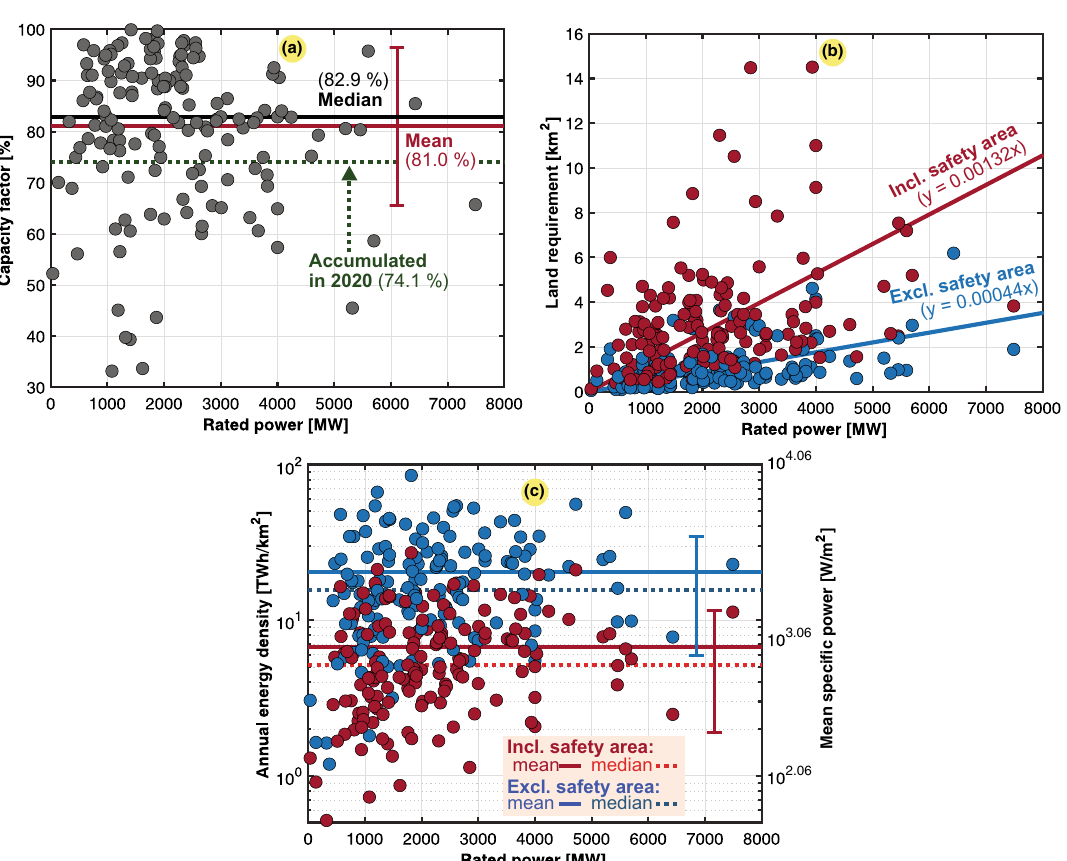
Figure 4. Scatter plots of the 159 nuclear power plants worldwide, 56 in Europe (1 in the Netherlands, 2 in Belgium, 19 in France, 6 in UK, 7 in Germany, 5 in Spain, 1 in Armenia, 2 in the Czech Republic, 2 in Finland, 1 in Hungary, 1 in Romania, 2 in Slovakia, 1 in Slovenia, 3 in Sweden, and 3 in Switzerland), 14 in the CIS (10 in Russia and 4 in Ukraine), 2 in the Middle East (1 in the United Arab Emirates and 1 in Iran), 1 in Africa (South Africa), 4 in Latin America (2 in Argentina, 1 in Brazil, and 1 in Mexico), 59 in North America (55 in the US and 4 in Canada), and 23 in Asia Pacific (4 in South Korea, 2 in Taiwan, 5 in Japan, 1 in the Philippines, 4 in China, 7 in India, and 2 in Pakistan). Typical, mean, median, and fitted values are also included. ( a ) Capacity factor ( C g ). ( b ) Land use ( A g ). ( c ) Annual energy density ( ε g ) or mean specific power ( p g